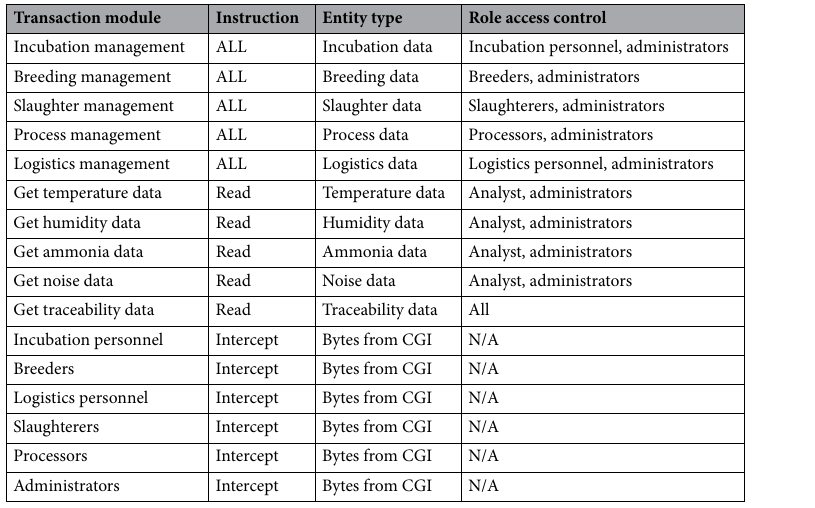
Figure 3. Smart contract architecture.